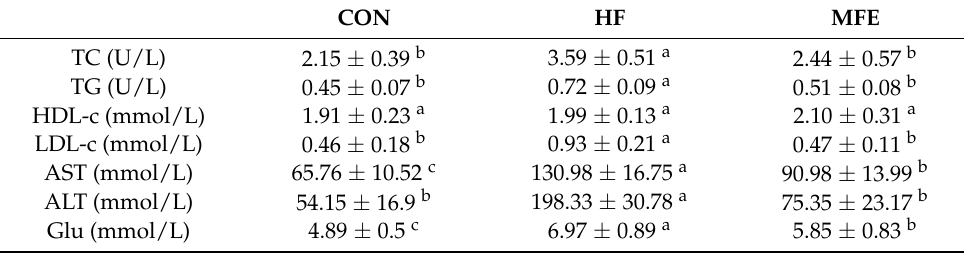
Table 3. The effect of MFE on serum biochemical indicators in high-fat-diet